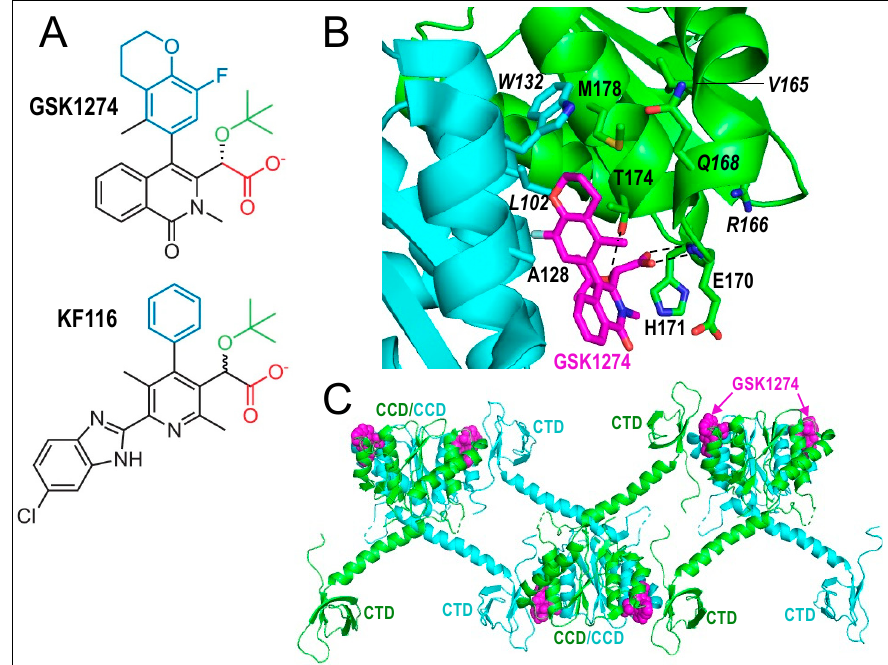
Figure 6. Representative ALLINI chemotypes and IN binding modes. ( A ) Structures of quinoline GSK1274 [222] and pyridine KF116 [223] compounds. See text for color descriptors. ( B ) X-ray crystal structure of GSK1274 bound to the IN CCD dimer (PDB accession code 4OJR [222]); the IN protein harbored the solubility-enhancing F185K substitution [74,232]. CCD dimerization interface residues in close contact to GSK1264 are shown. Nearby Val165 and Arg166 are additionally highlighted. Amino acid residues that when mutated yield class IIb (Val165, Gln168) or class IIc (Leu102, Trp132, Arg166) IN mutant viruses are labeled in italics. Atoms are colored as follows: red, oxygen; blue, nitrogen; mustard, sulfur; and light blue, fluorine. Dashed lines, hydrogen bond interactions. ( C ) Structure depicting ALLINI-induced IN hyper-multimerization (PDB accession code 5HOT [230]). The full-length IN construct harbored Y15A and F185H amino acid substitutions. The IN NTD was not resolved in the electron density map; other domains are indicated. GSK1264 is colored magenta in panels B and C.